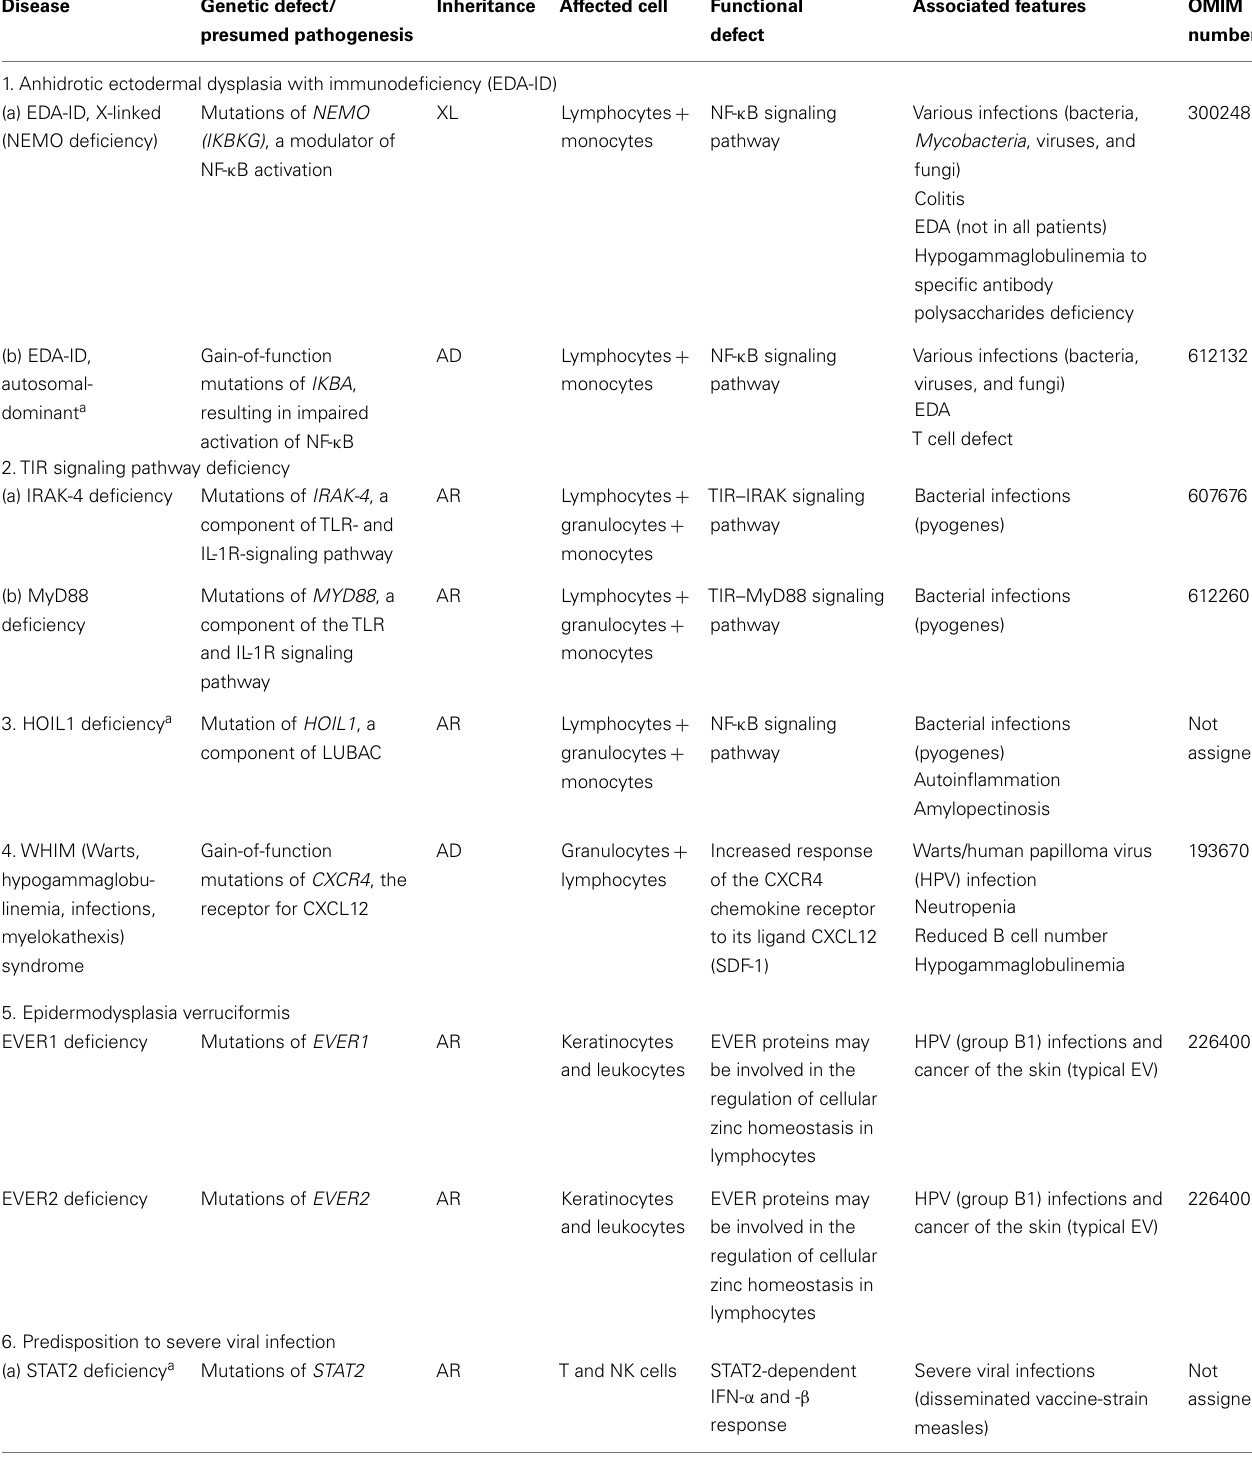
Table 6 | Defects in innate